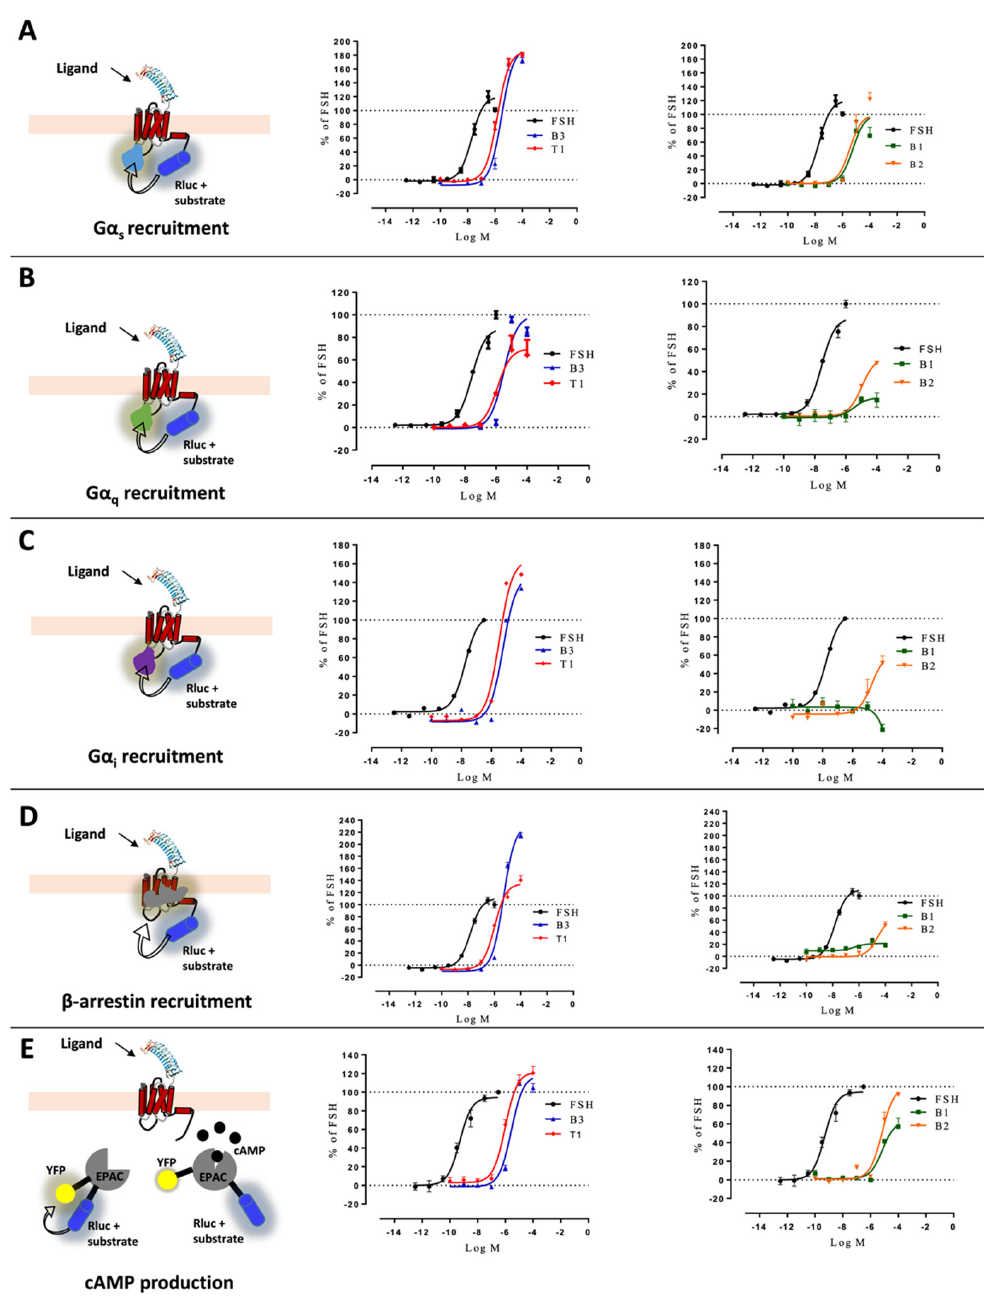
Figure 2. Profiling of LMW ligands vs. FSH in HEK293 cells. ( A ) G α s recruitment (light blue), ( B ) G α q recruitment (green), ( C ) G α i recruitment (purple), ( D ) β -arrestin 2 recruitment (grey), and ( E ) cAMP production were measured. HEK293 cells transfected with the FSHR and the appropriate BRET sensors (Rluc stands for renilla luciferase, YFP for yellow fluorescent protein, and EPAC for exchange protein directly activated by cAMP) were challenged with increasing doses of FSH (10 − 12.5 to 10 − 6.5 M) or LMW ligands (10 − 10 to 10 − 4 M). Concentration/activity curves were measured for the different read-outs. Signals were monitored for 30 min and normalized, considering the FSH maximal response as 100%. The area under the concentration/activity curves generated by each compound was plotted and fitted using non-linear regression. Data are represented as mean ± SEM from at least six independent experiments.